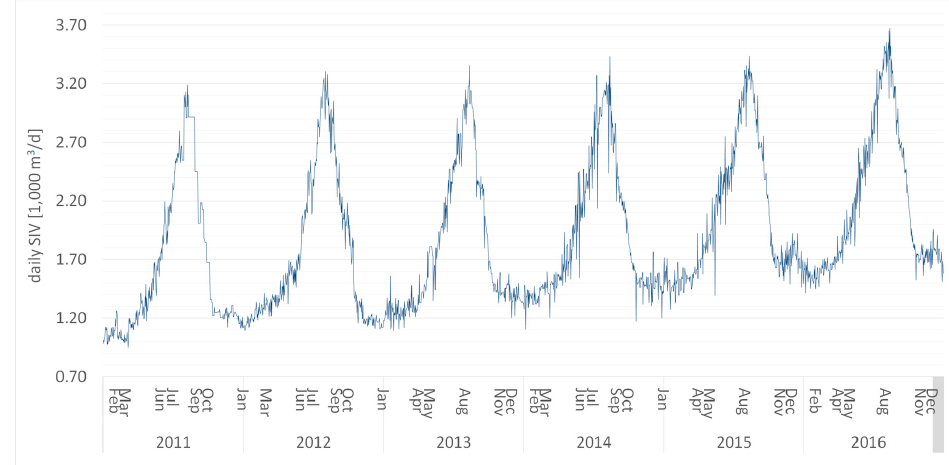
Figure 7. Daily SIV (with an accuracy range of ± 1%) following an intense seasonal pattern with summer peaks and winter lows.